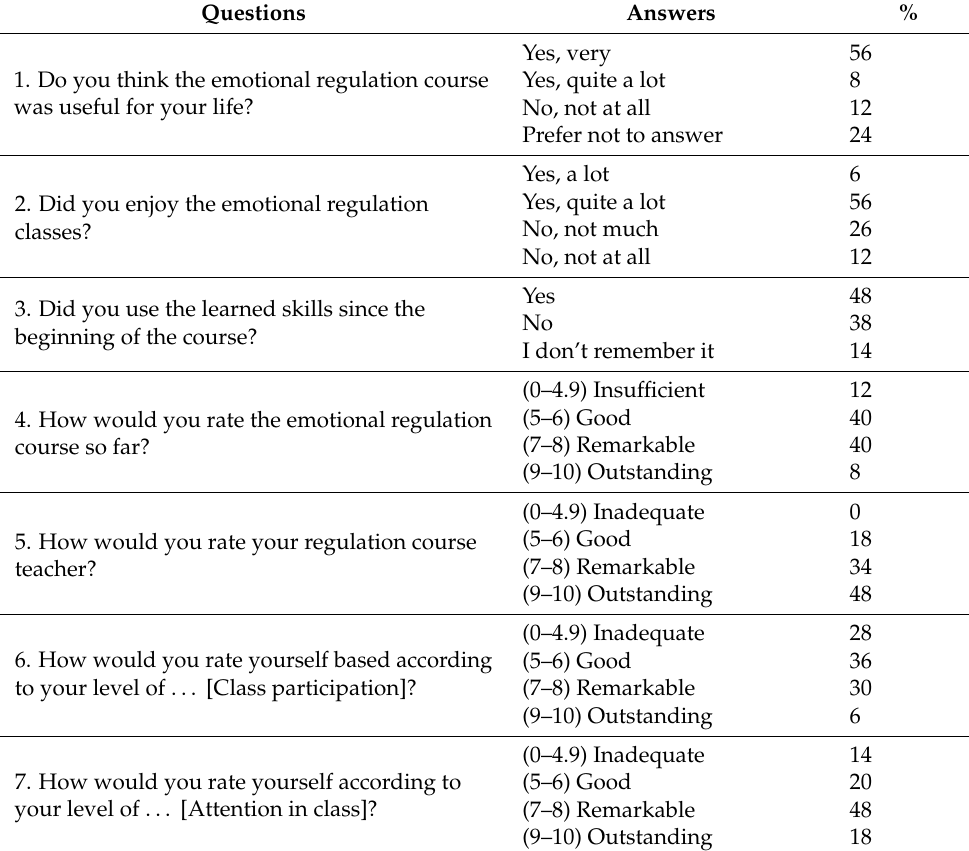
Table 2. Results of program satisfaction after one academic year of DBT STEPS-A (n =